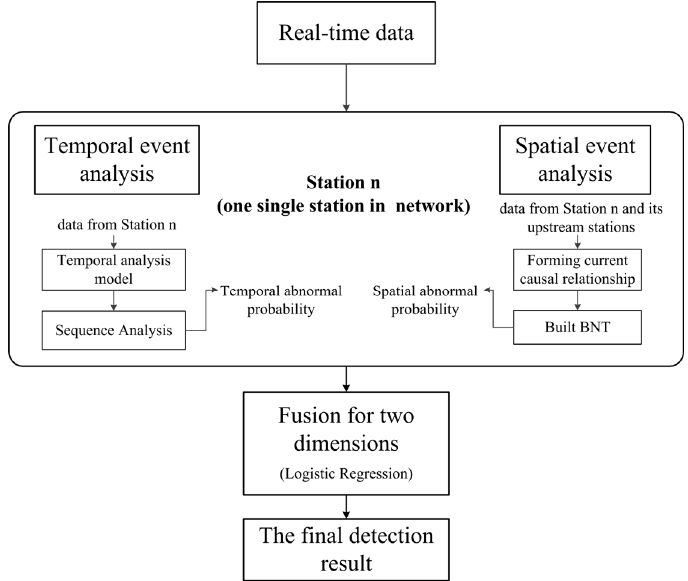
Figure 1. Framework of the proposed model.